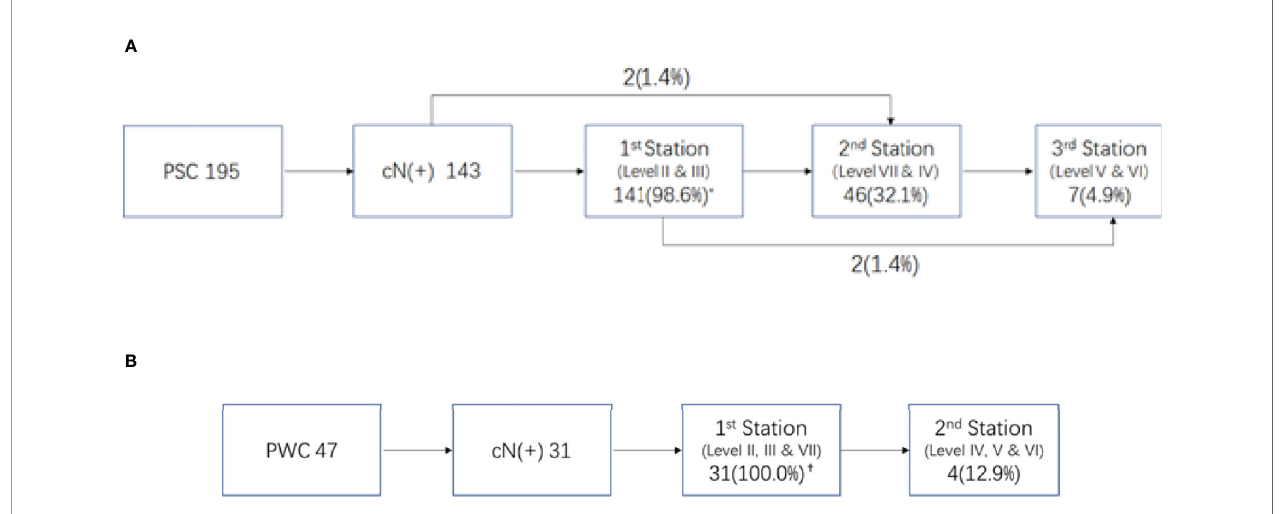
FIGURE 2 | Lymphnode metastasis pattern in different primary site of hypopharyngeal cancer. (A) Pattern of LNM in piriform sinus cancer (PSC) * Percent of LNMs in 143 N(+) patients. (B) Pattern of LNM in posterior wall (PPC). † Percent of LNMs in 31 N(+)